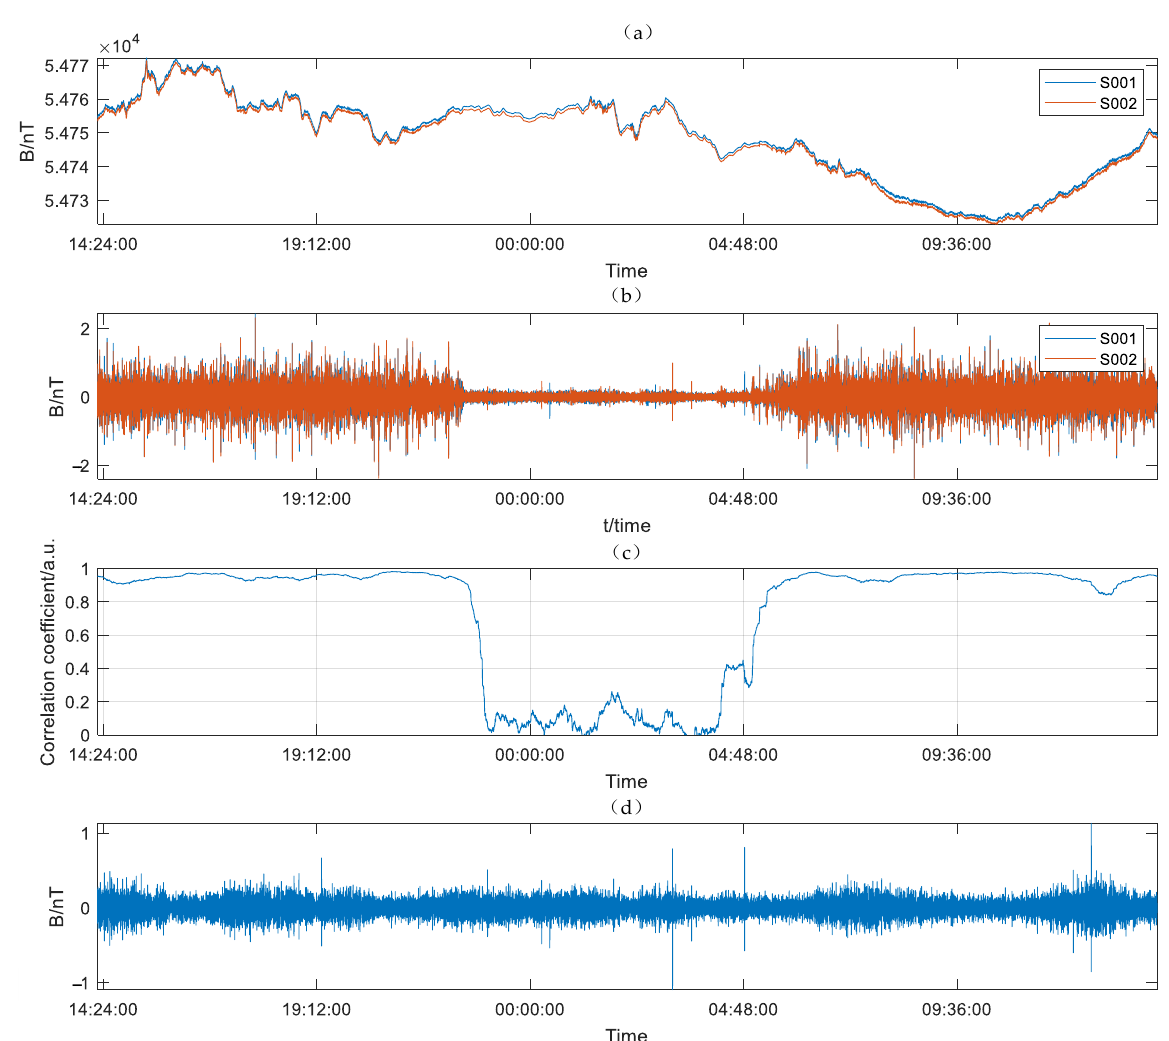
Figure 17. ( a ) 24 h magnetic field value, ( b ) fourth-order difference of the magnetic field, ( c ) correlation coefficient of S001 and S002, ( d ) difference value of the fourth-order difference.